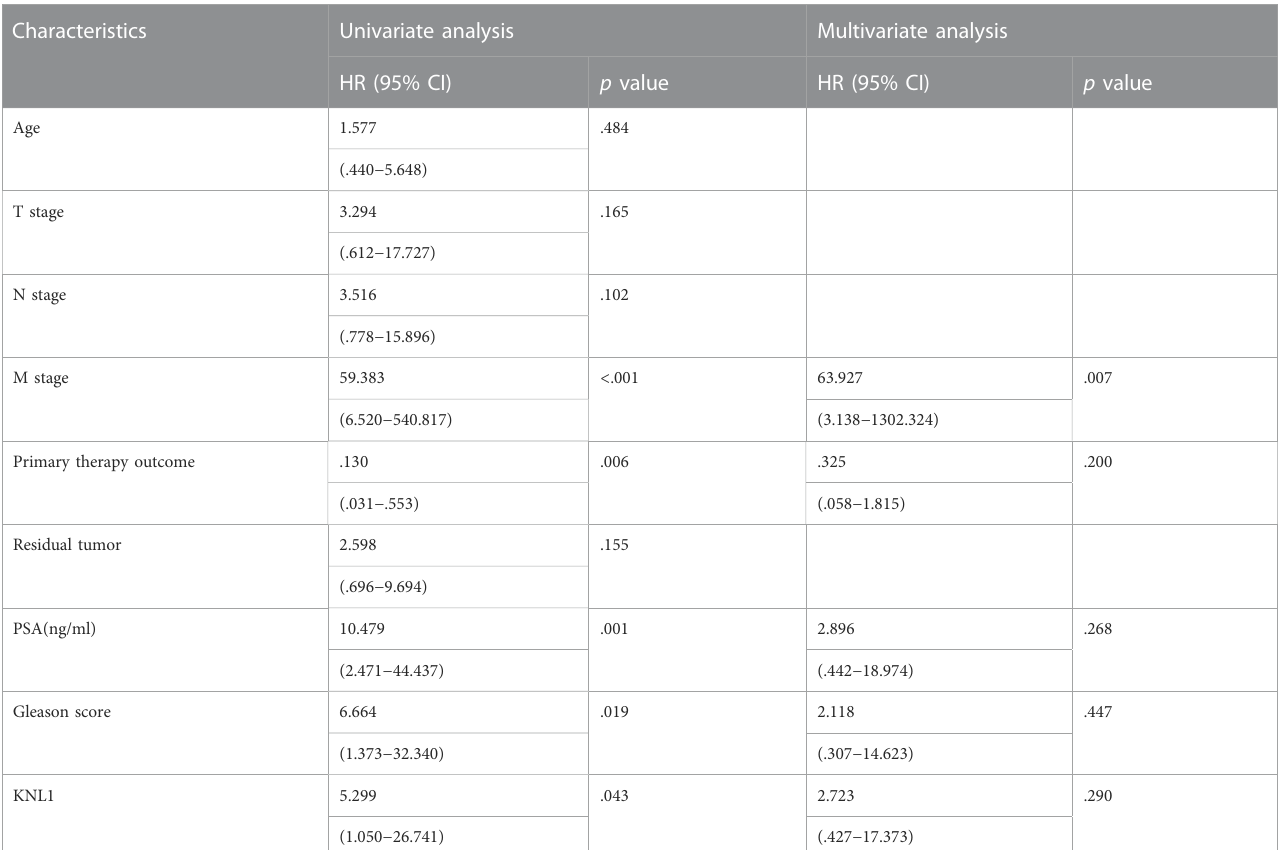
TABLE 2 Univariate and multivariate Cox analysis of clinicopathological parameters and OS in patients with PRAD.